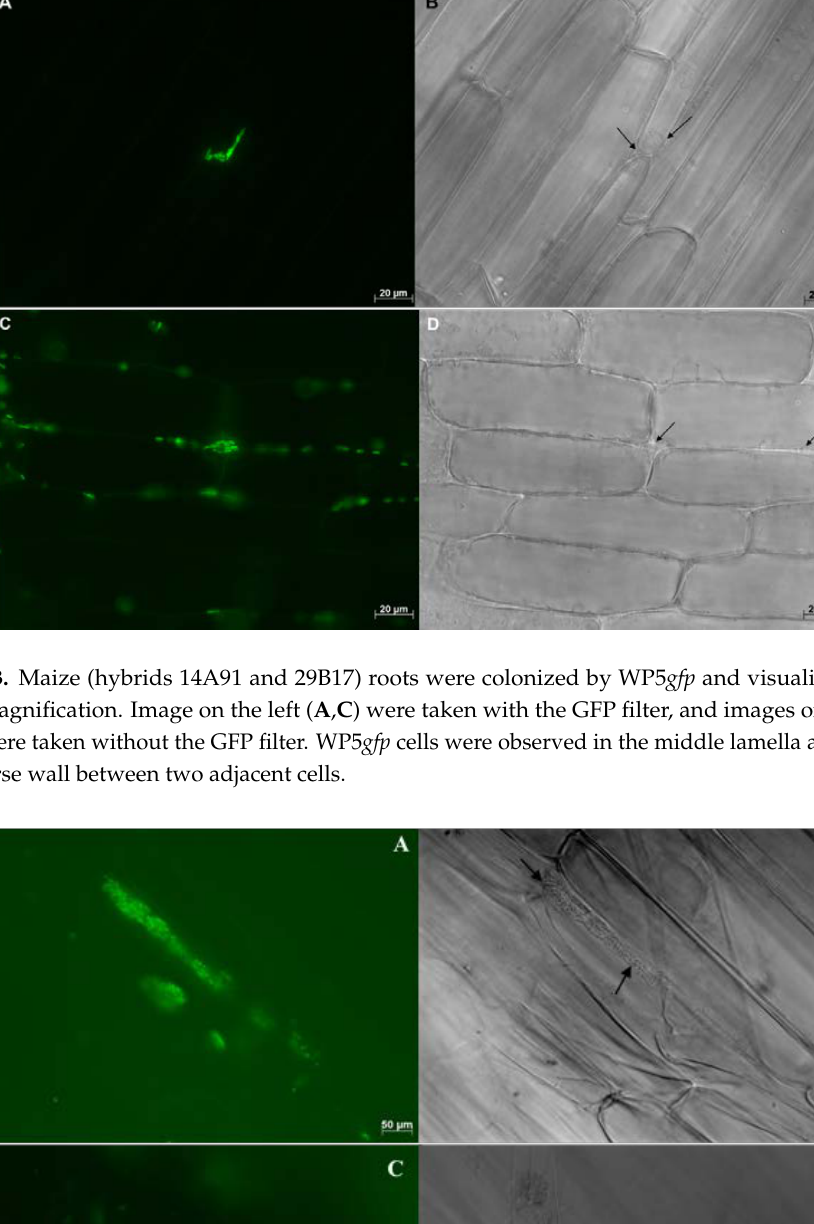
Figure 2. Maize (hybrid 29B17) roots colonized by WP5 gfp visualized under 630× magnification. Image on the left ( A , C ) were taken with the GFP filter, and images on the right ( B , D ) were taken without the GFP filter. Groups of WP5 gfp cells were observed in the intercellular spaces of cell layers in the longitudinal direction.